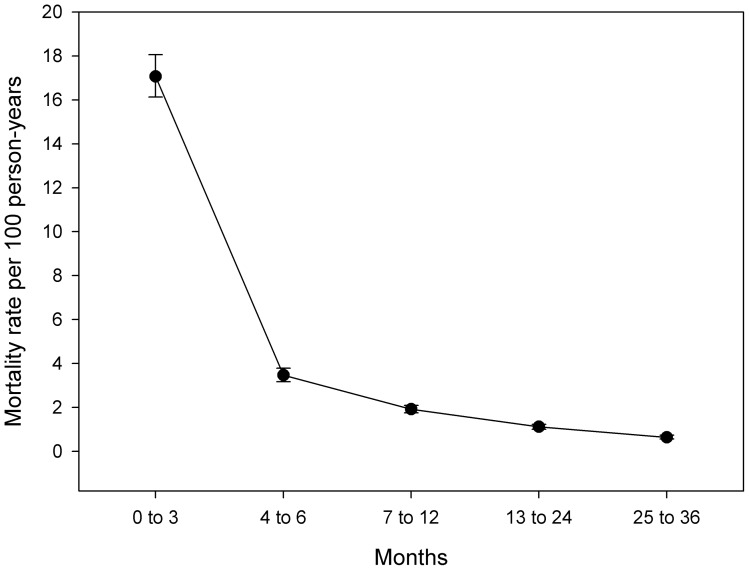
Mortality rates in time periods after commencement of anti-retroviral therapy.